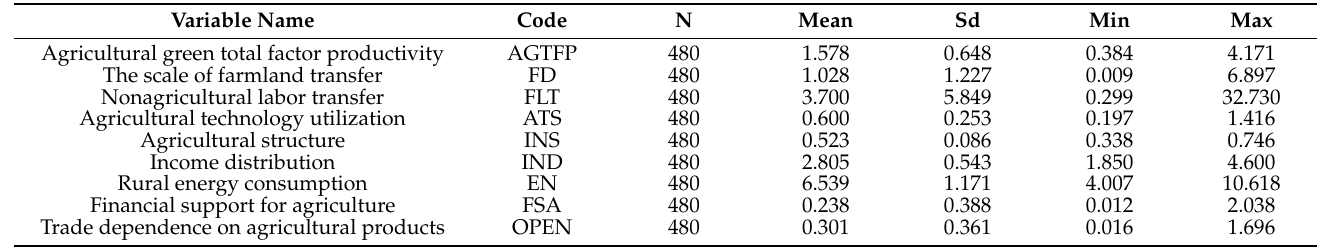
Table 2. Descriptive Statistical of Variables.